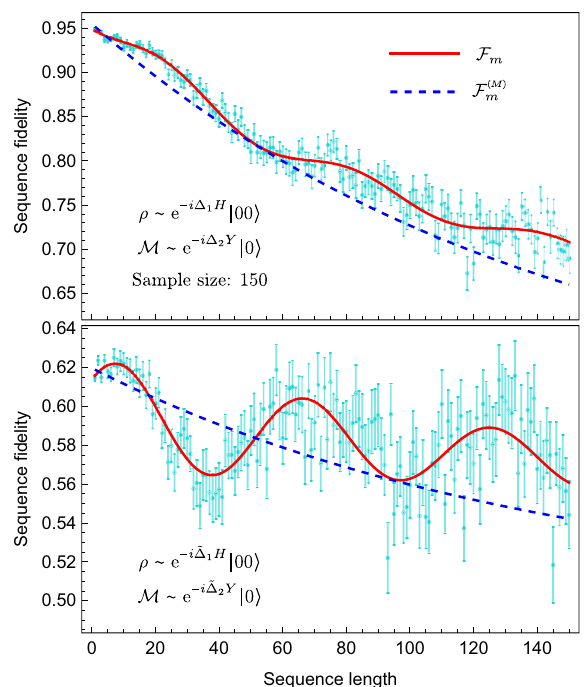
FIG. 5. Effect of SPAM errors in the two-qubit spin noise in Eq. (24). We consider the noise model described by the two- spin interaction of Eq. (24) with δ ≈ 0.03, J = 1.7, h x = 1.47, and h y = − 1.05, for a single qubit as system S . On both plots, the continuous (red) line denotes analytical ASF in Eq. (7), with each point joined for clarity, dots denote numerical aver- age of the ASF over 150 samples, with bars being the standard deviation of the mean (uncertainty of the numerical mean from the true mean), and the dashed (blue) line denotes the analyt- ical ASF of the Markovianized process. Top: the initial state ) ρ = | 00 (cid:8)(cid:9) 00 | is affected by the sequence noise (cid:3) ∼ exp ( − i (cid:12) 1 H for a small (cid:12) 1 ≈ 0.04 and M = | 0 (cid:8)(cid:9) 0 | is slightly rotated via (cid:3) ∼ exp ( − i (cid:12) ) with a small (cid:12) ≈ 0.09. Bottom: ˜ (cid:12) ≈ 0.29 2 Y 2 1 and (cid:12) 2 ≈ 0.10 are increased considerably, amounting to large SPAM errors. In all cases the sample size is